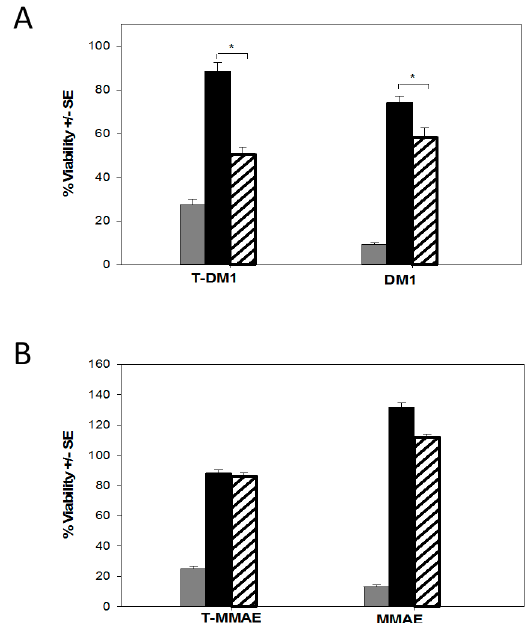
Figure 7. Role of BCRP in BT-474 cells that survived T-DM1 or T-MMAE treatments. ( A ) Cytotoxicity of T-DM1 and DM1 was measured against BT-474 cells (grey bars) and T-DM1 surviving BT-474 cells with (hashed bars) or without (black bars) 10 µM Ko143; ( B ) Cytotoxicity of T-MMAE and MMAE was measured against BT-474 (grey bars) and T-MMAE surviving BT-474 cells with (hashed bars) or without (black bars) 10 µM Ko143. * indicates significant difference ( p < 0.05).